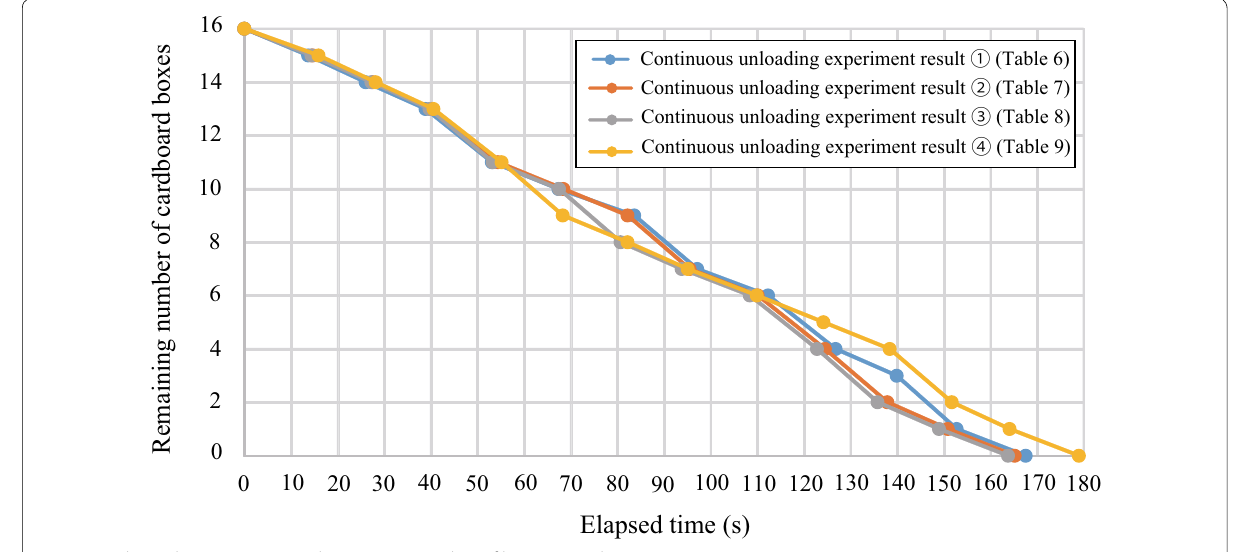
Fig. 44 Relation between time and remaining number of boxes in each